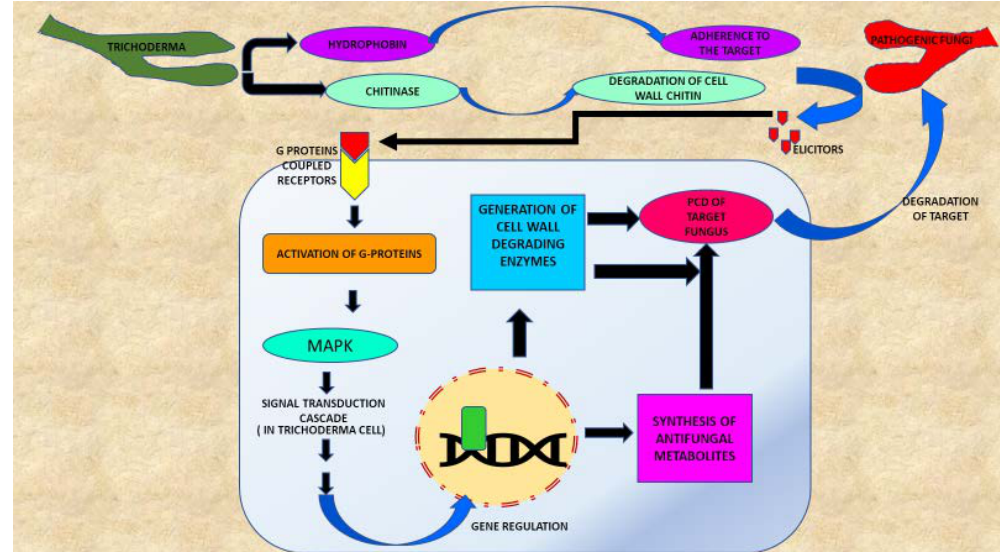
Figure 3. Mode of action of Trichoderma spp. in destroying pathogenic fungi. Trichoderma releases the lytic enzymes in the rhizosphere, which catalyzes the cell wall damage to target fungi. After this, a signaling cascade is activated in Trichoderma cells which involves the activation of MAPK (mitogen-activated protein kinase) through G-protein-coupled receptors. Alteration in gene expression ultimately leads to PCD (programmed cell death) of pathogenic fungi.